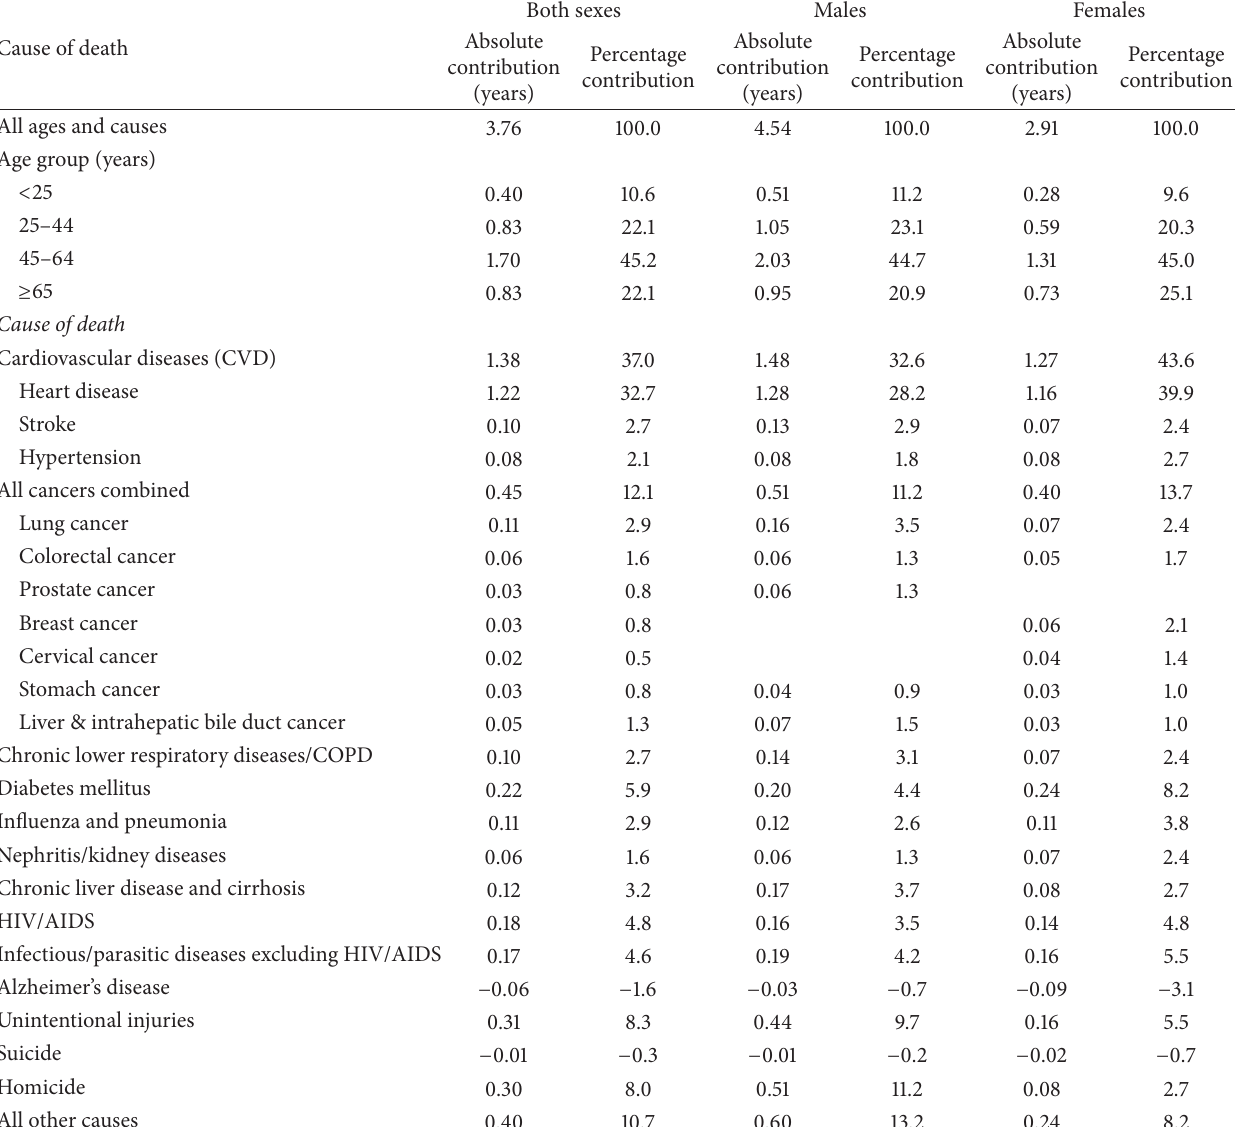
Table 3: Contribution of specific age groups and leading causes of death to the gap in life expectancy at birth between low and high unemployment areas of the United States,